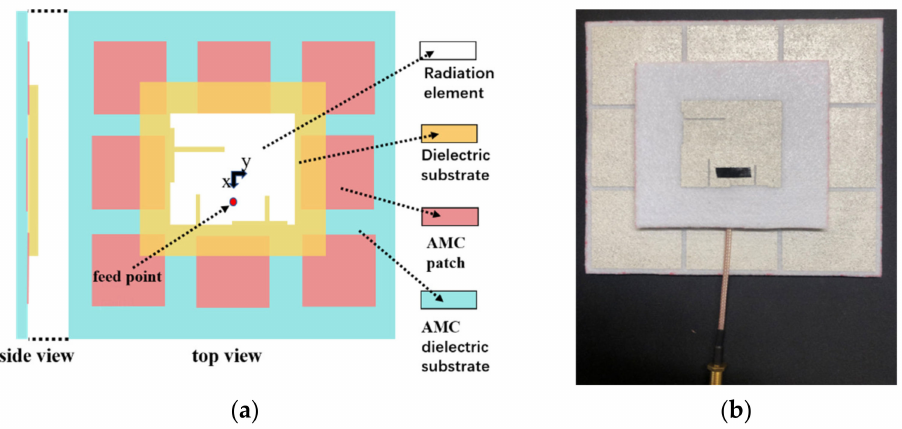
Figure 9. Textile slotted microstrip antenna loaded with AMC: ( a ) designed and ( b ) prototype figure.